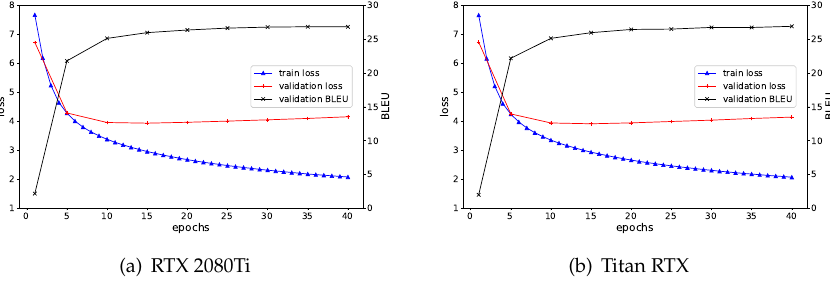
Figure 7. The training process on RTX 2080Ti ( a ) and Titan RTX ( b ).